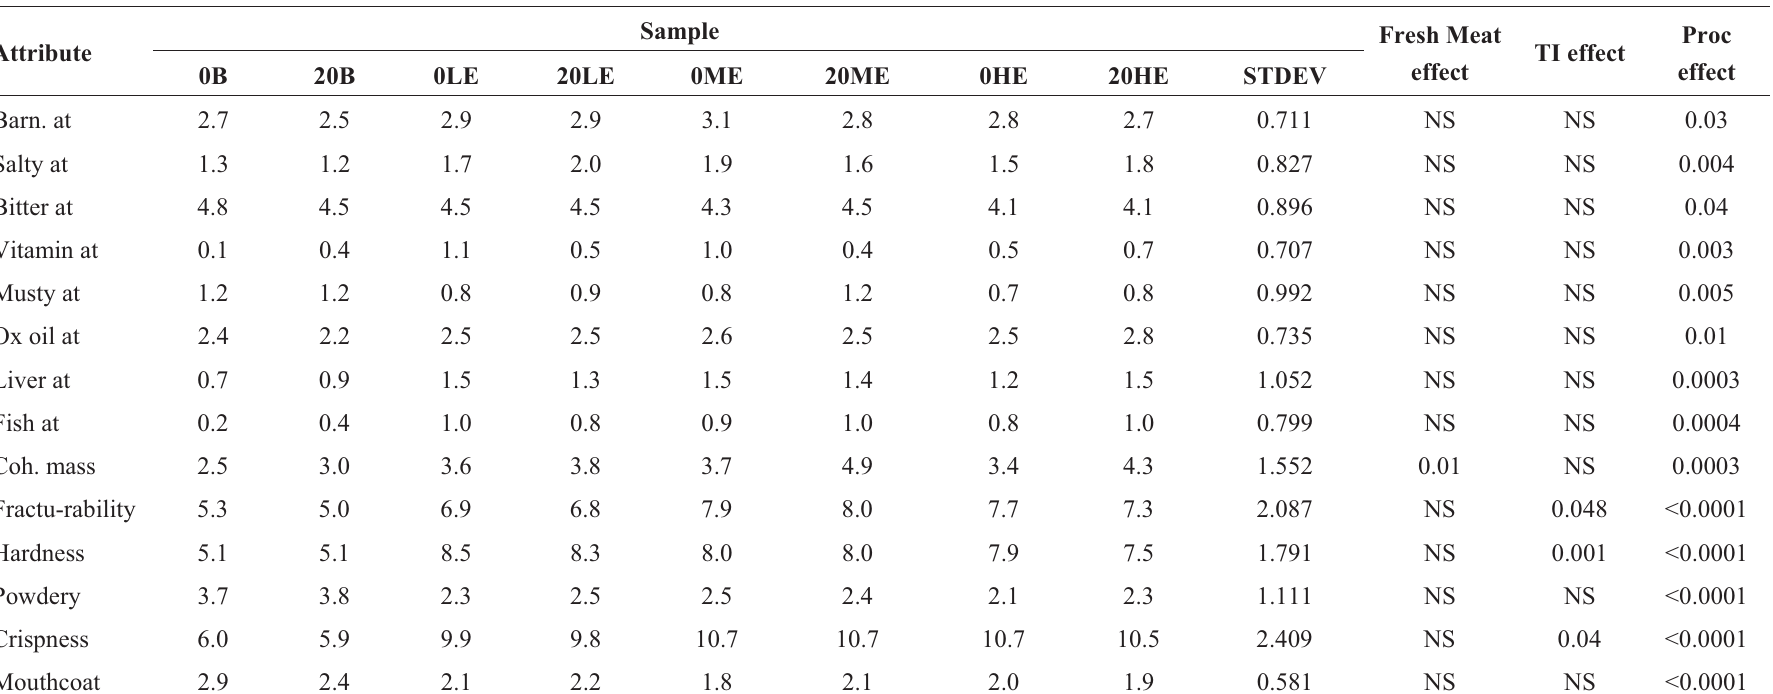
Table 2b. Descriptive sensory analysis attributes mean values, formulation and processing